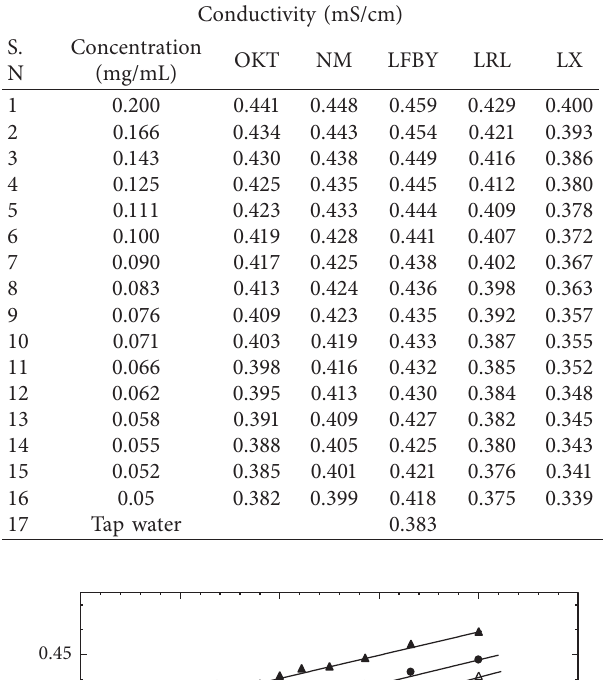
Table 1: Concentration against specific conductivity of different soap samples.